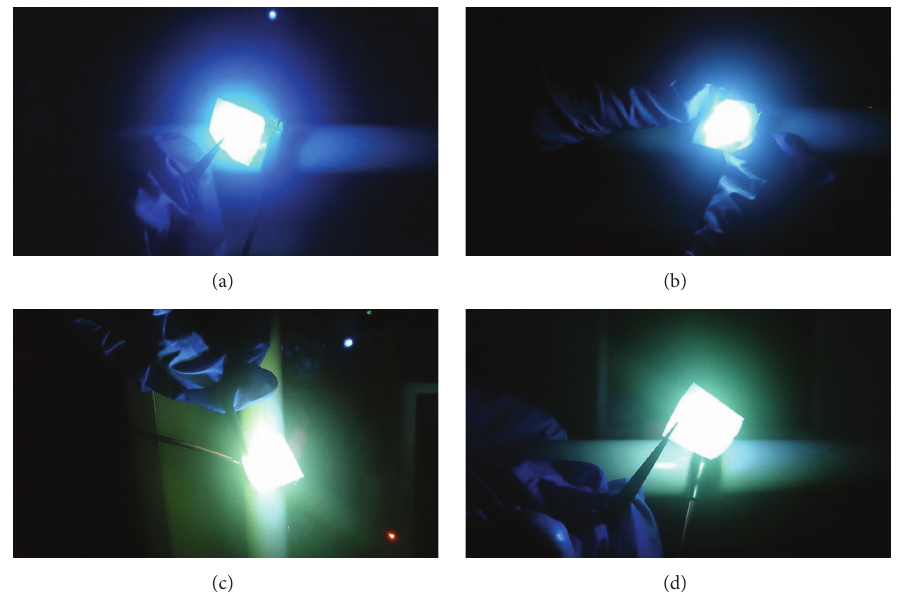
Figure 5: Operating photos of LED on YAG-PDMS substrates with various incorporation amounts: (a) 10%, (b) 20%, (c) 30%, and (d) 40% concentration of